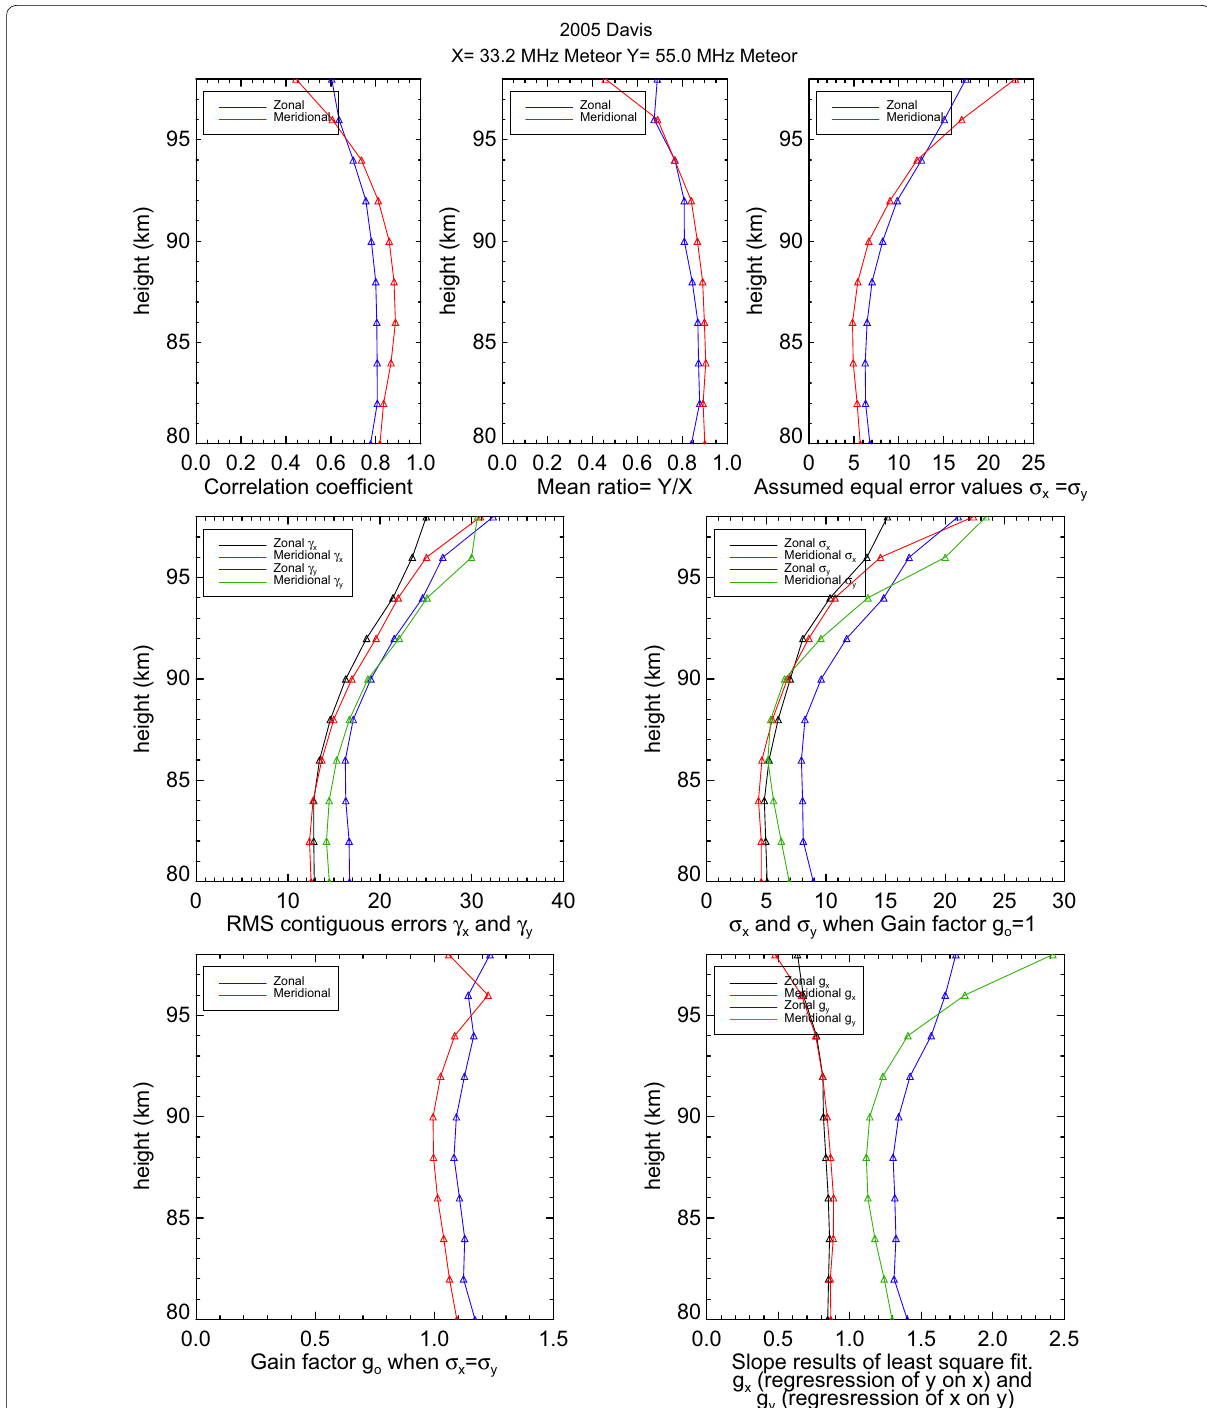
Fig. 4 Summary plot for all heights for 2005 for the parameters shown in Fig. 3. The panels show (from left to right and top to bottom) the cor- relation coefficients, the ratio of zonal and meridional wind magnitudes measured by the 55 and 33.2 MHz meteor radars, the values of σ x and σ y , the RMS contiguous errors γ x and γ y , the values of σ x and σ y , when g 0 = 1.0 , the value of g 0 assuming that σ x = σ y , and the slopes of the standard linear regressions of the 55 MHz results against the 33.2 MHz radar and the 33.2 MHz radar against the 55 MHz. In the fourth, fifth, and last panels, red and black indicate the 33.2 MHz radar and green and blue the 55 MHz radar